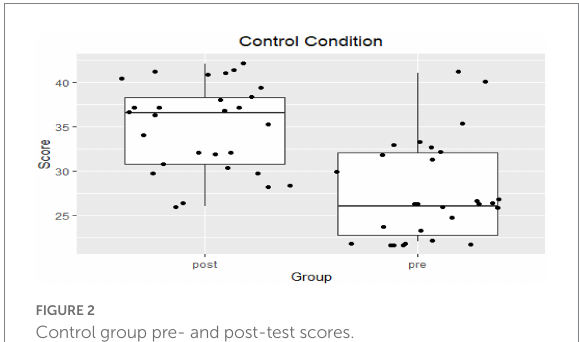
FIGURE 2 Control group pre- and post-test scores.